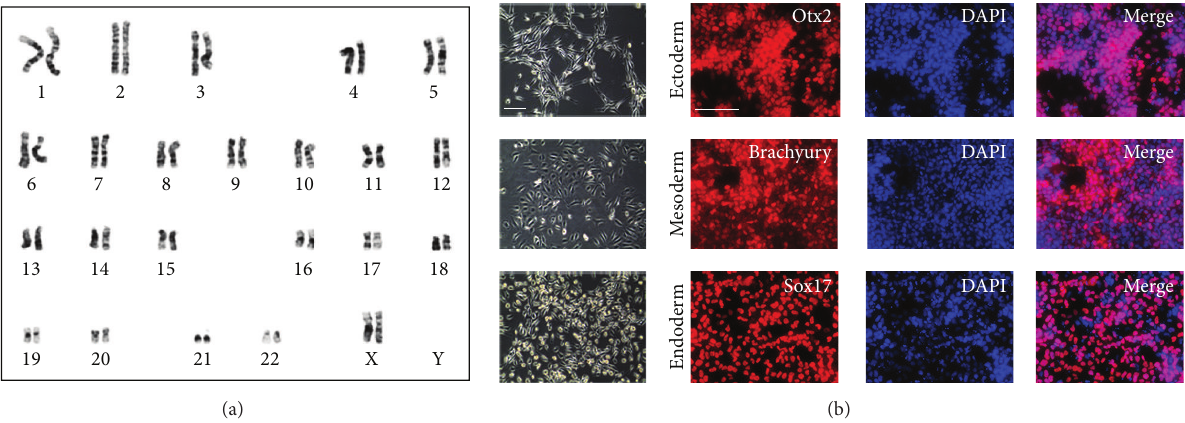
Figure 3: Further detailed characterization of N3. (a) High-resolution, G-banded karyotype of N3. Data show that the cell has a normal 44+XX chromosomal content. (b) Potential differentiation ability of N3 was confirmed using functional identification staining. Scale bars: 200 𝜇